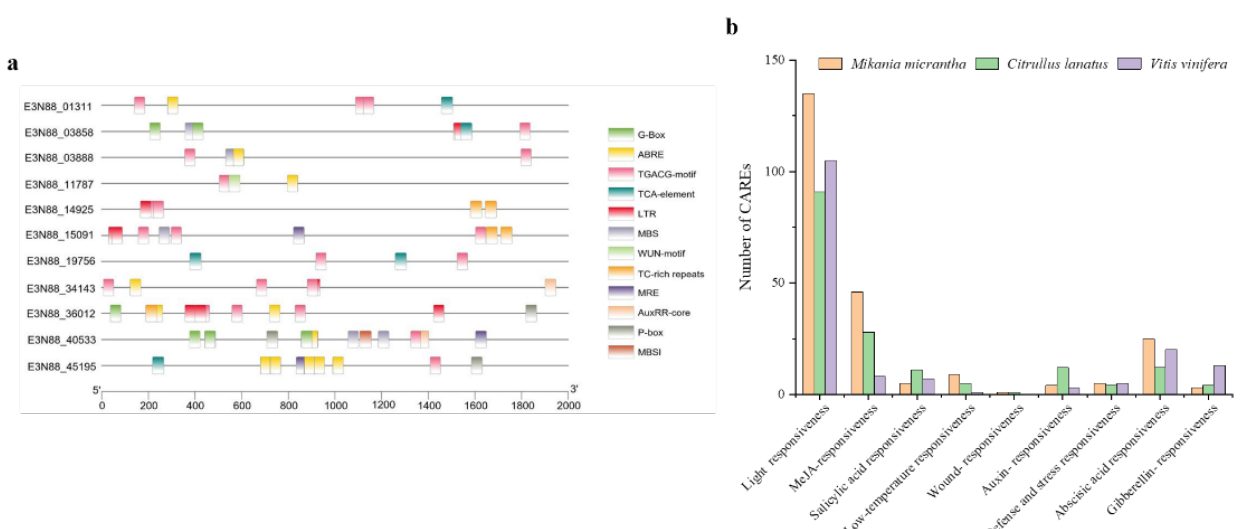
Figure 7. Analysis of cis-acting regulatory elements (CAREs) of the PIN gene family. ( a ) Putative CAREs of the PIN gene family in M. micrantha . Twelve cis-acting regulatory elements commonly found in PIN genes are shown with different colored squares, respectively. ( b ) Number of response- related CAREs of the PIN gene family in three vines.